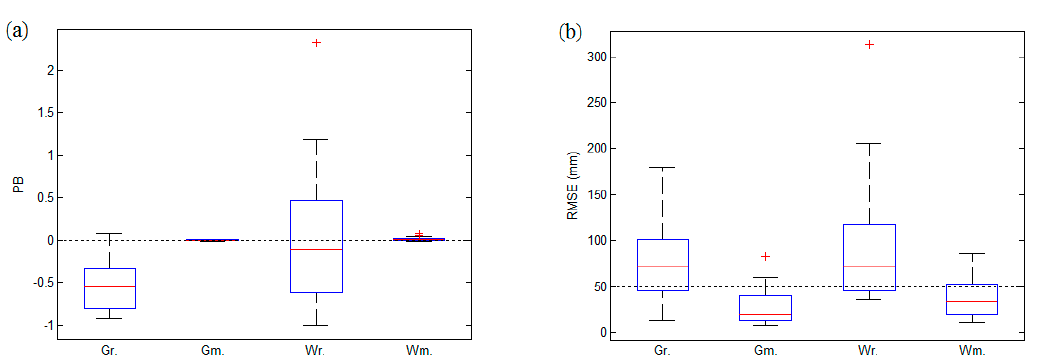
Figure 6. Metrics of cumulative rainfall of Gr, Gm, Wr and Wm on the highest rainfall day at 9 rain gauges based on all events: ( a ) PB and ( b ) RMSE. The red line is the median and red plus is the outlier defined as points below the 5th percentiles or above 95th percentiles.